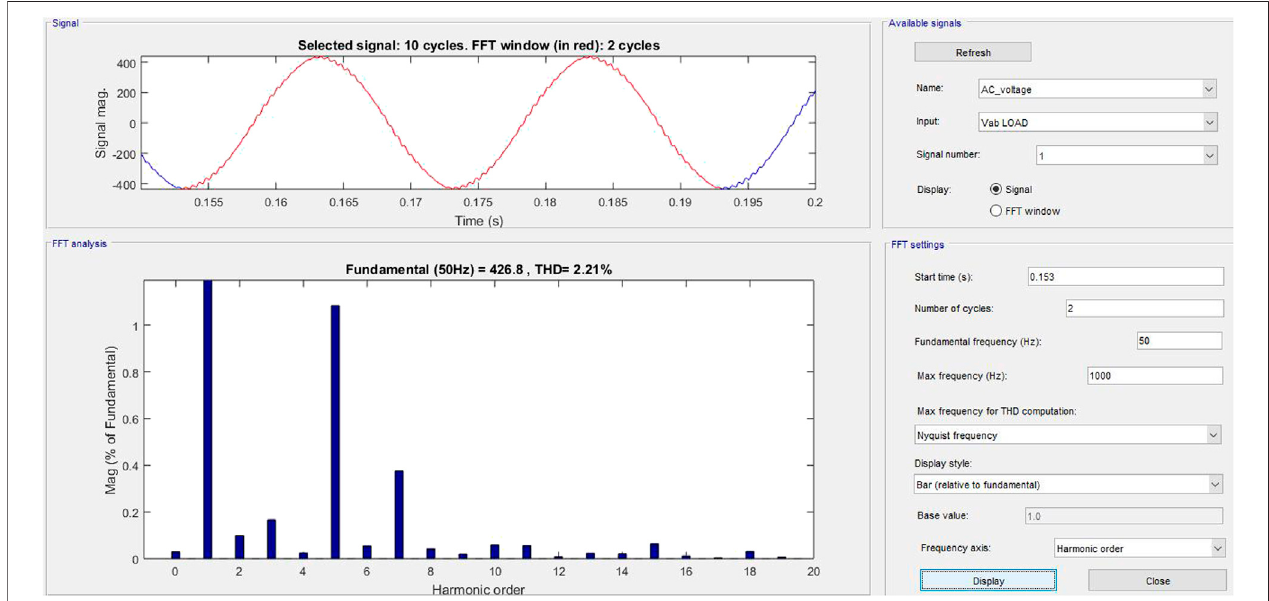
FIGURE 4 | Total harmonic distortion after fi ltering.